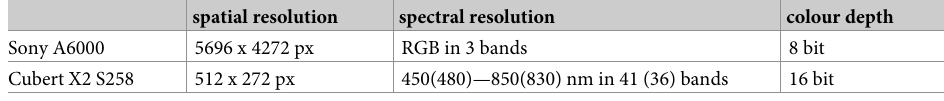
Table 3. Technical specifications of the camera systems used throughout this